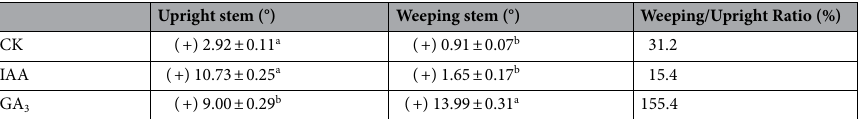
Table 1. Differences between upright and weeping stems in response to 2 mg/L IAA and GA 3 treatments. The data showed the deviation angle of the stem from the horizontal direction, ( +) represents bending in a negative gravity direction. Different letters indicate a significant difference ( P < 0.05) based on one-way ANOVA. Error bars represent one standard error of the mean (n =